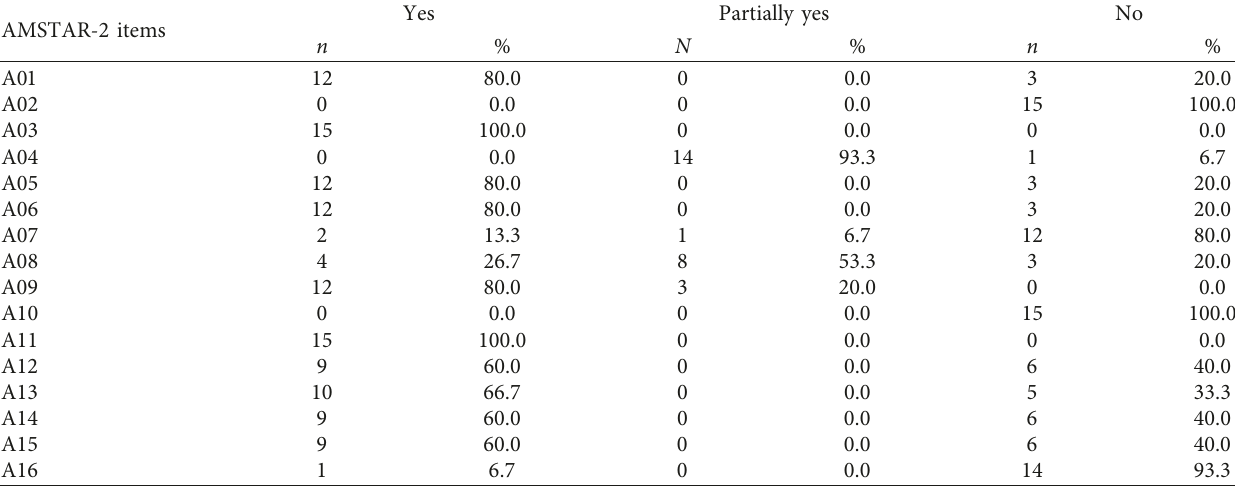
Table 3: AMSTAR-2 assessment table.